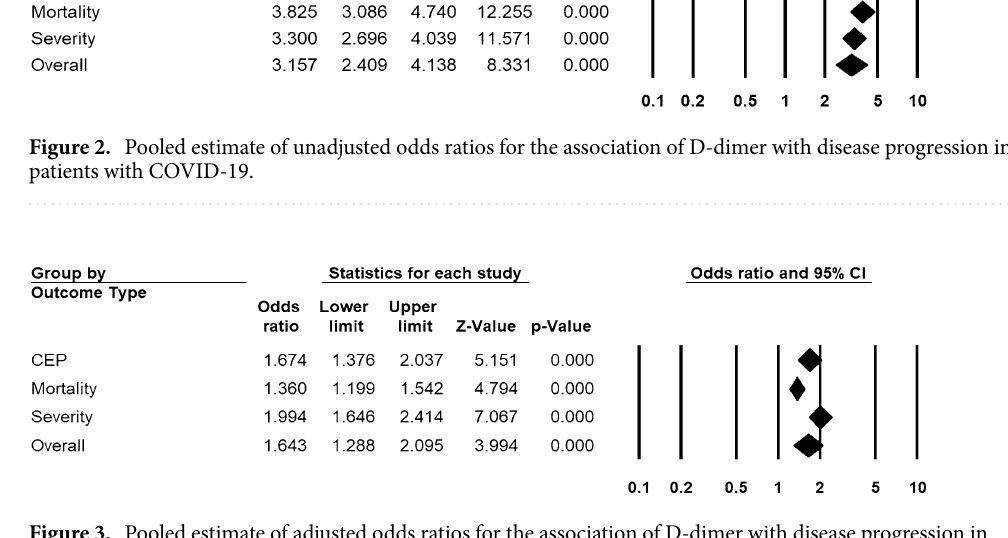
Figure 3. Pooled estimate of adjusted odds ratios for the association of D-dimer with disease progression in patients with